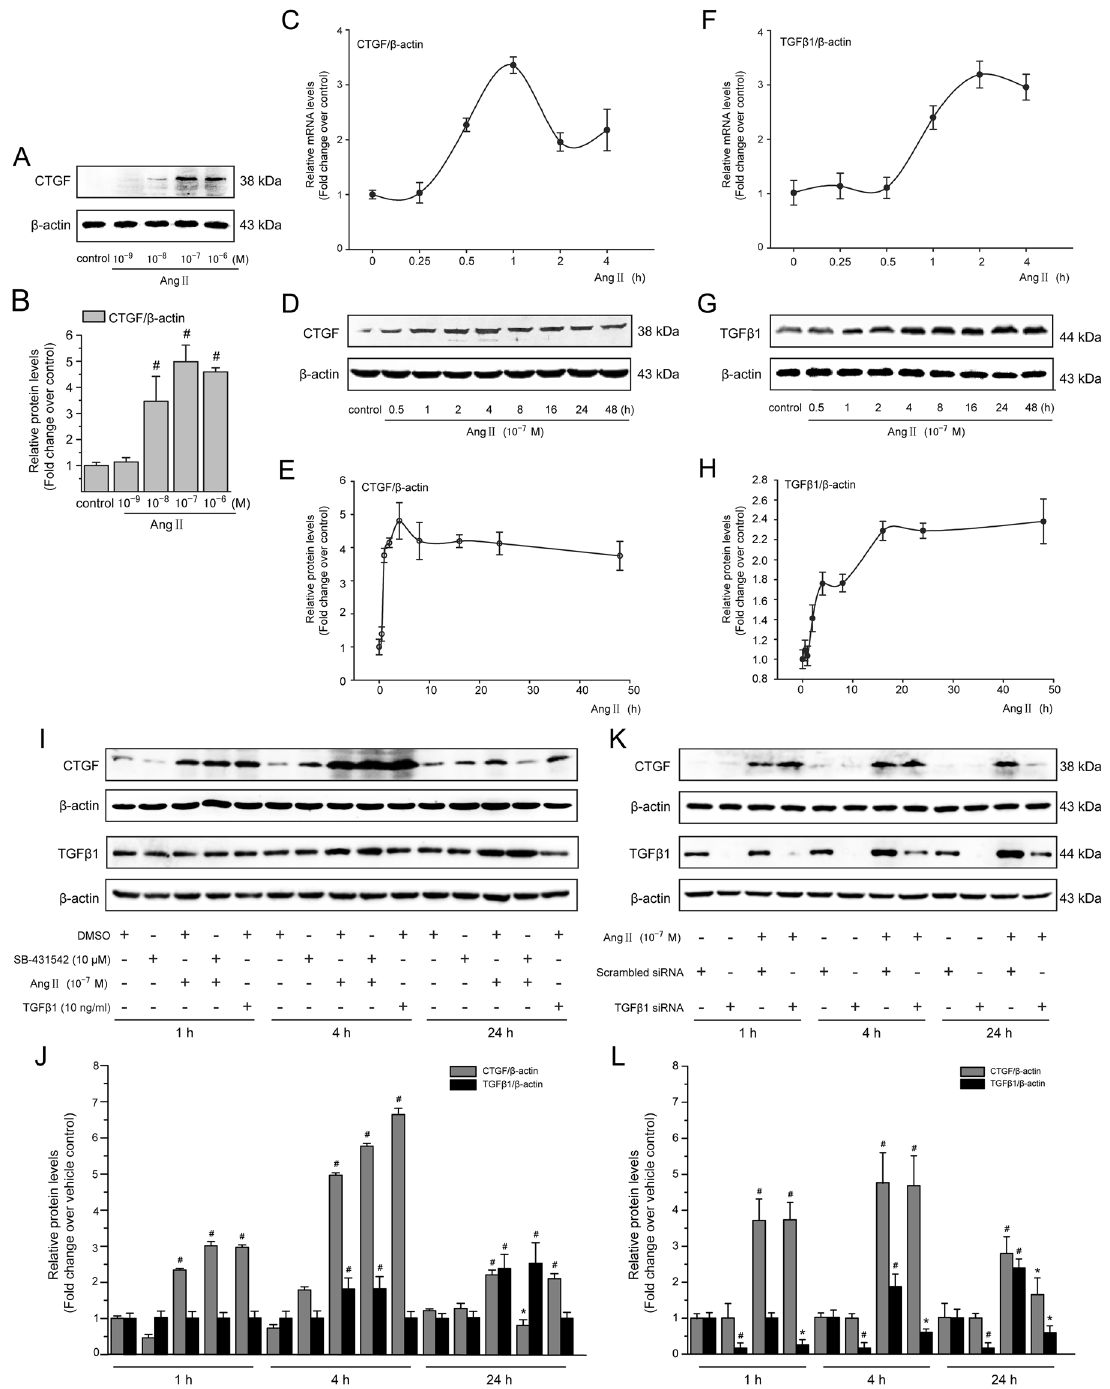
Figure 1. Ang II induces a rapid upregulation of CTGF expression independently of TGF- β in LX-2 cells. ( A ) Serum-starved LX-2 cells were stimulated with Ang II (10 − 8 –10 − 6 M) for 4 h. Whole cell lysates were immunoblotted with CTGF antibody and a representative immunoblot band of CTGF from 3 independent experiments is shown. β -Actin was used as an internal control for equal protein loading. ( B ) Results of total CTGF expression were obtained from densitometric analysis and expressed as ratio CTGF/ β -actin, as n - fold increase over that in unstimulated control cells. ( C,F ) Serum-starved LX-2 cells were exposed to Ang II (10 − 7 M) for 0, 0.25, 0.5, 1, 2 and 4 h. The mRNA expression of the TGF- β 1 and CTGF gene was measured by the qRT-PCR method as described in the Materials and Methods section. ( D,G ) Serum-starved LX-2 cells were exposed to Ang II (10 − 7 M) for 0, 0.5, 1, 2, 4, 8, 16, 24 and 48 h. Whole cell lysates were prepared and immunoblotted with anti-CTGF or anti-TGF- β 1 antibodies, respectively. Anti- β -actin antibody was used to demonstrate equal protein loading. Similar results were observed in 3 independent experiments, and representative immunoblot bands of CTGF and TGF- β 1 are shown. ( E,H ) Quantitative determination of